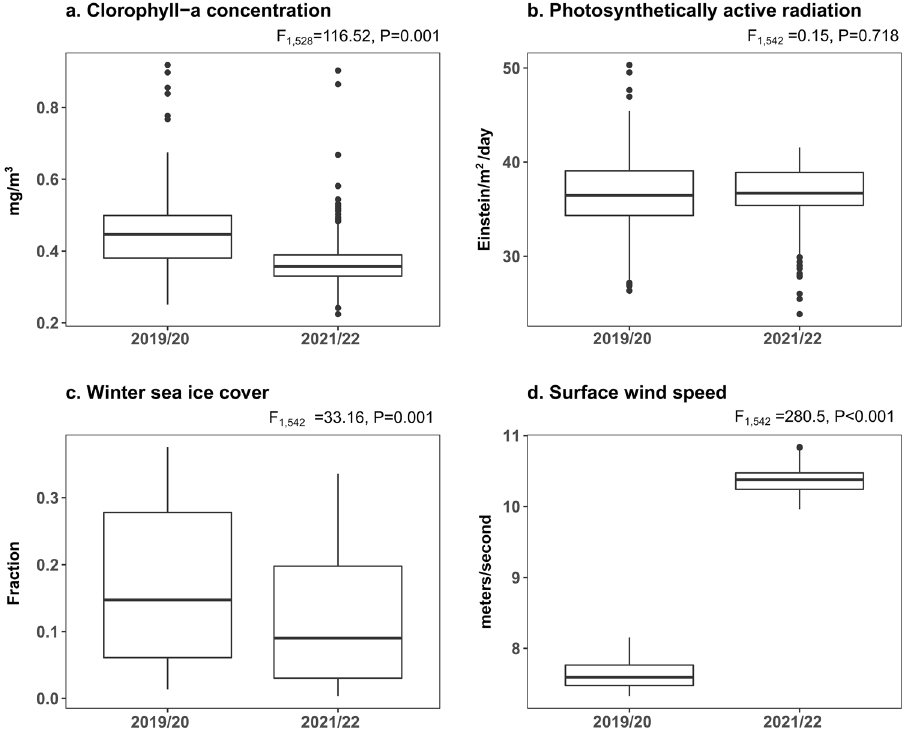
Figure 4. Seasonal differences of spring–summer chlorophyll-a concentration ( a ), spring–summer photosynthetically active radiation ( b ), winter sea ice cover ( c ) and spring–summer surface wind speed ( d ) in a 75 km radius around Harmony Point, Nelson Island in two different seasons. Statistical results from Permutational Analysis of Variance (999